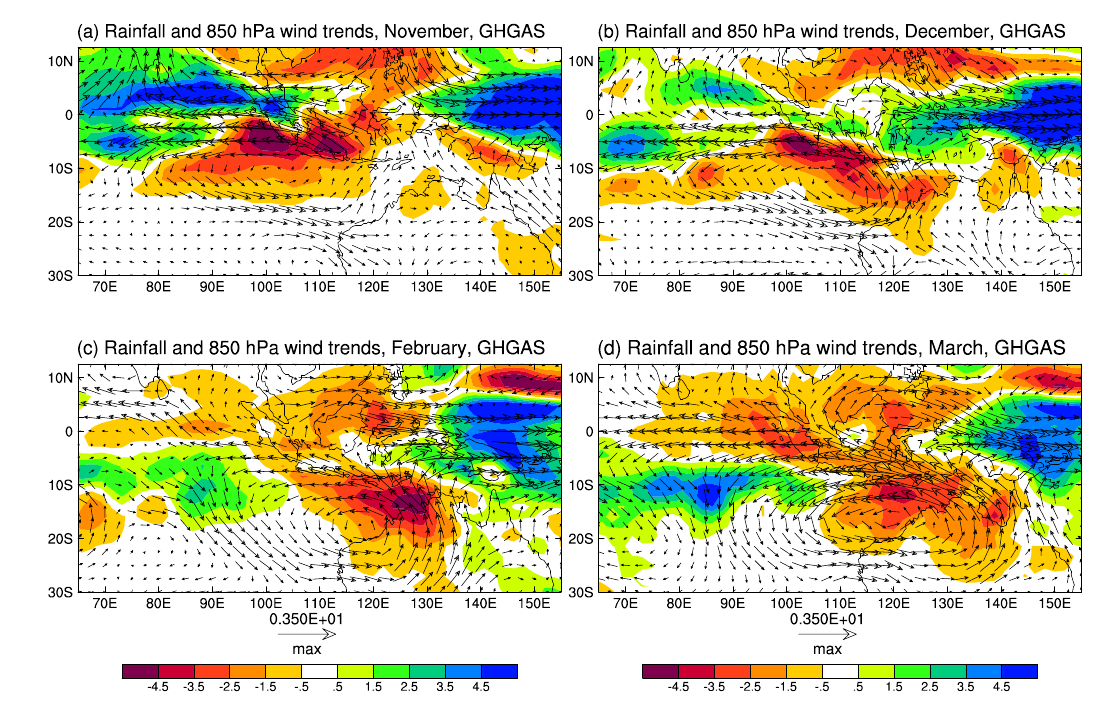
Fig. 22. 1951–2010 GHGAS ensemble-mean trends of rainfall (shading, mmday − 1 century − 1 ) and 850 hPa wind (vectors, ms − 1 century − 1 ), for (a) November, (b) December, (c) February and (d)